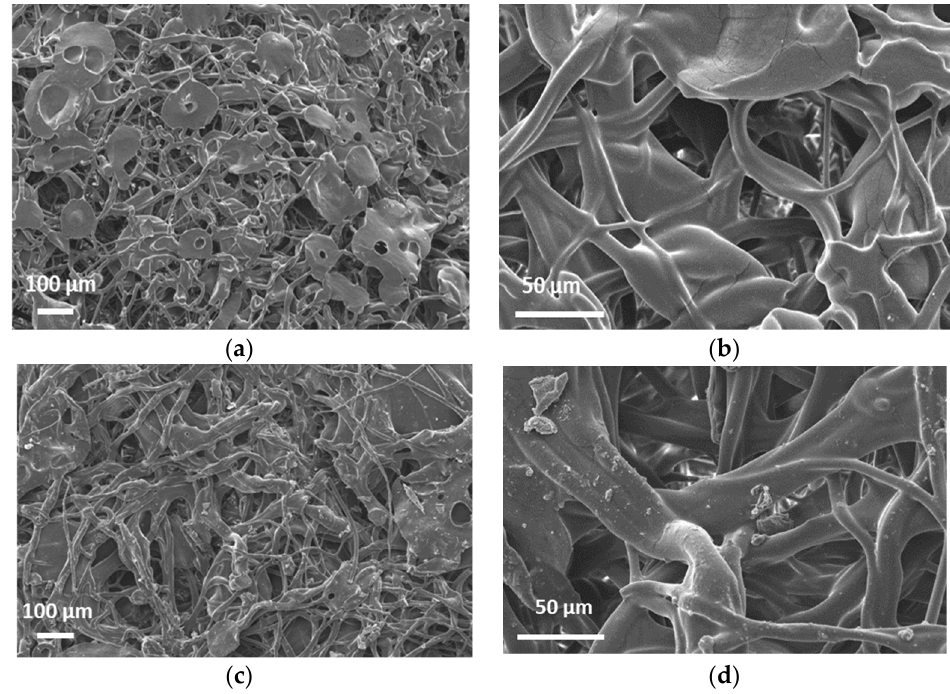
Figure 2. SEM micrographs of the 203.75 g/m 2 ( a , b ) and the 295.5 g/m 2 mats ( c , d ).